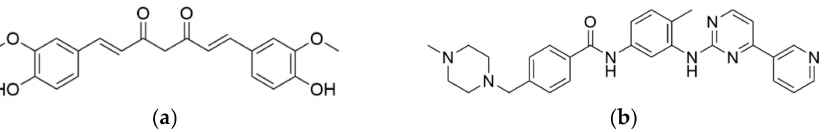
Figure 1. Chemical structures of curcumin ( a ) and imatinib ( b ). 2D structures of the curcumin and imatinib molecules were prepared using Spartan 14